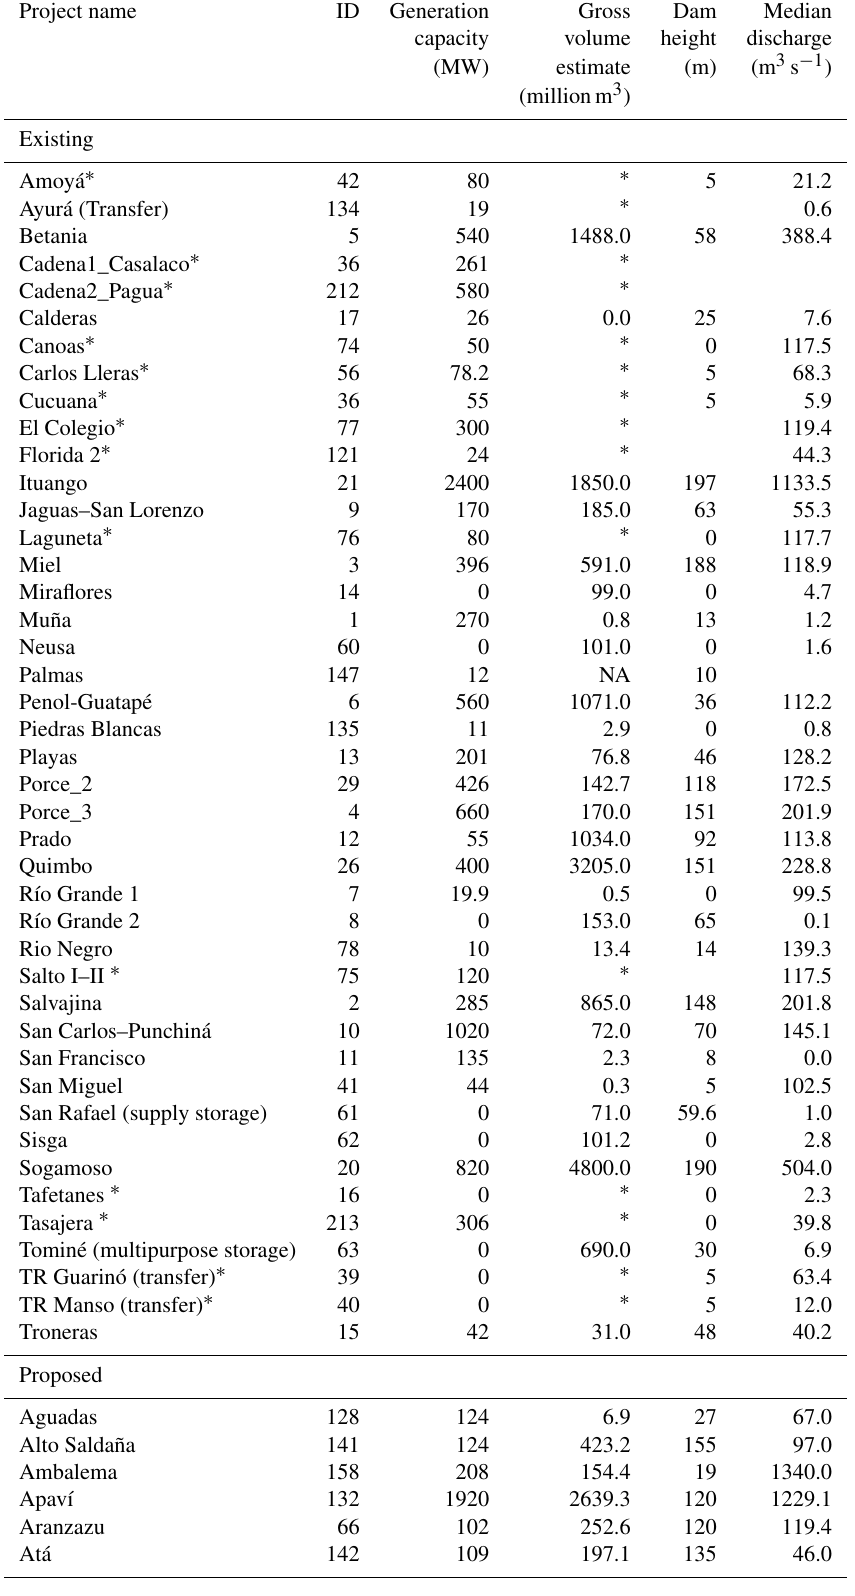
Table 1. Existing and proposed hydropower projects and other related infrastructure in the MRB, used to identify dam